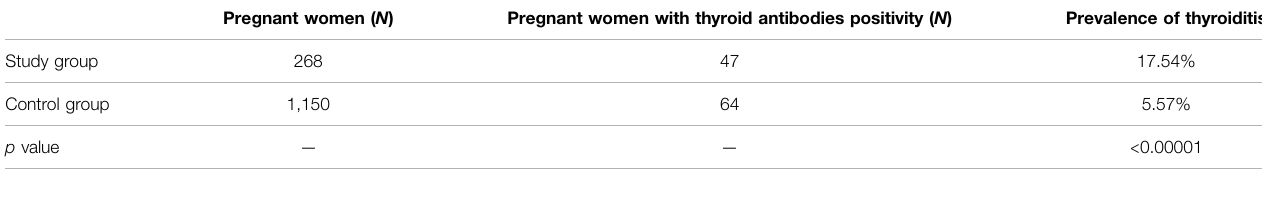
TABLE 1 | Prevalence of thyroiditis in the Study group of pregnant women with autoimmune diseases and in the Control group of pregnant women.